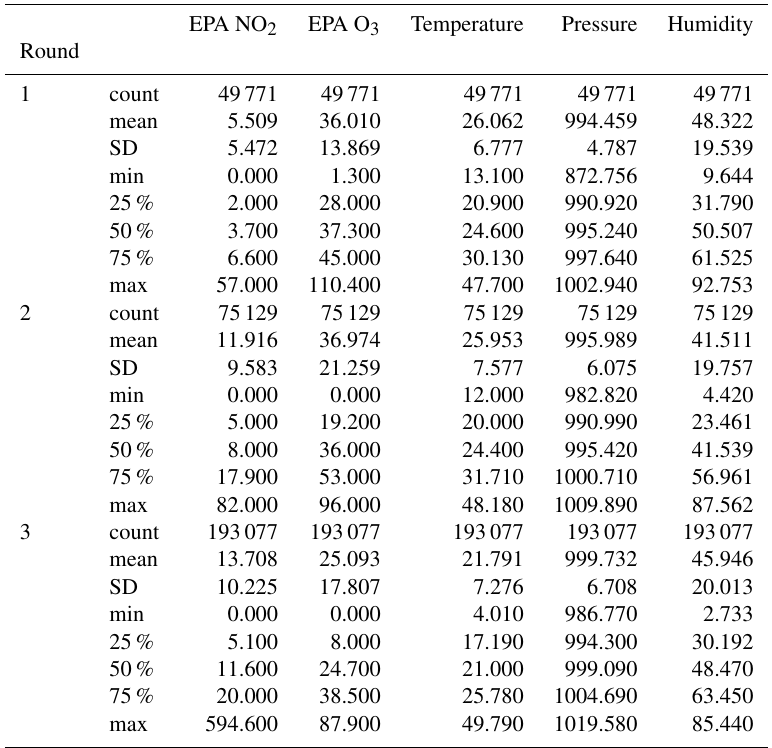
Table B2. Summary of data set grouped by